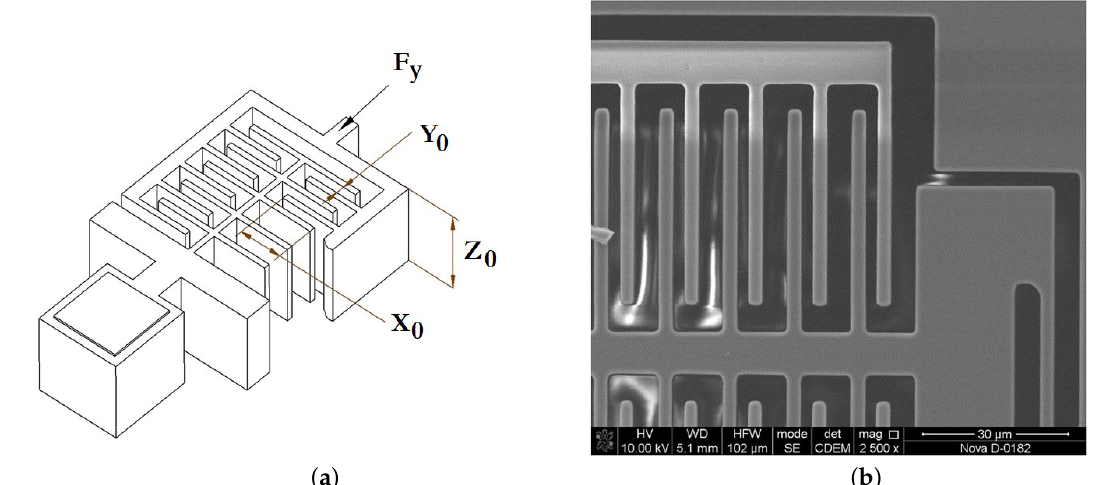
Figure 10. Electrostatic comb counter-pin vibration drive: ( a ) schematic view; ( b ) SEM